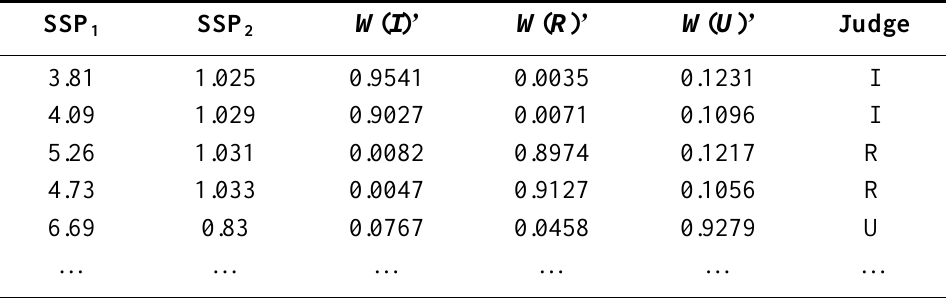
Table 11. Verification result of third